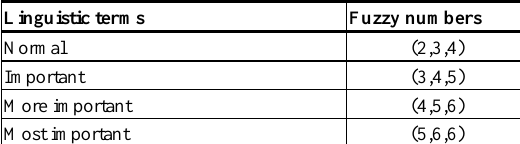
Table 1. Linguistic terms for describing weights of